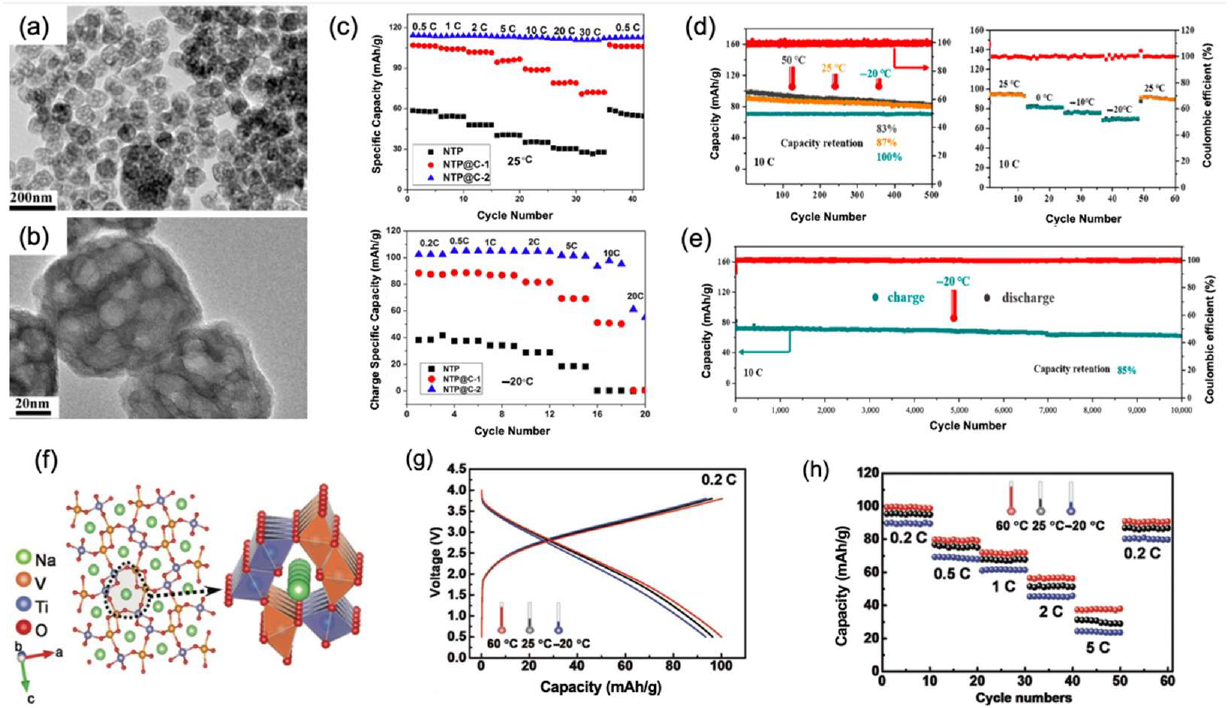
Figure 8. ( a ) Optical image of NTP@C-2 in 200 nm. ( b ) Optical image of NTP@C-2 in 20 nm. ( c ) Electrochemical performance of NTP (black), NTP@C-1 (red), and NTP@C-2 (blue). The picture above represents these three anodes at 25 ◦ C, while the picture below represents these three anodes at − 20 ◦ C. Reproduced with permission from Ref. [52]. Copyright American Chemical Society. ( d ) In the figure on the left, the blue line represents the full cell’s electrochemical performance tested at − 20 ◦ C, the yellow line represents it tested at 25 ◦ C, and the black line represents it tested at 50 ◦ C with a high rate of 10 C. The figure on the right shows it cycles in different temperatures at 10 C. ( e ) Full cell tested for ultra-long 10,000 cycles at − 20 ◦ C with a high rate of 10 C. Reproduced with permission from Ref. [54]. Copyright 2019 American Chemical Society. ( f ) Schematic illustration of microstructure of NaV 1.25 Ti 0.75 O 4 . ( g ) Electrochemical performance of the NaV 1.25 Ti 0.75 O 4 /Na 0.8 -Ni 0.4 Ti 0.6 O 2 full cell. The red, black, and blue lines represent the full cell tested at 60 ◦ C, 25 ◦ C, and − 20 ◦ C with rate of 0.2 C, respectively. ( h ) The stability of the full cell was tested when the rate changed in a range from 0.2 C to 5 C at temperatures of 60 ◦ C, 25 ◦ C, and − 20 ◦ C. Reproduced with permission from Ref. [55]. Copyright 2018 WILEY-VCH.